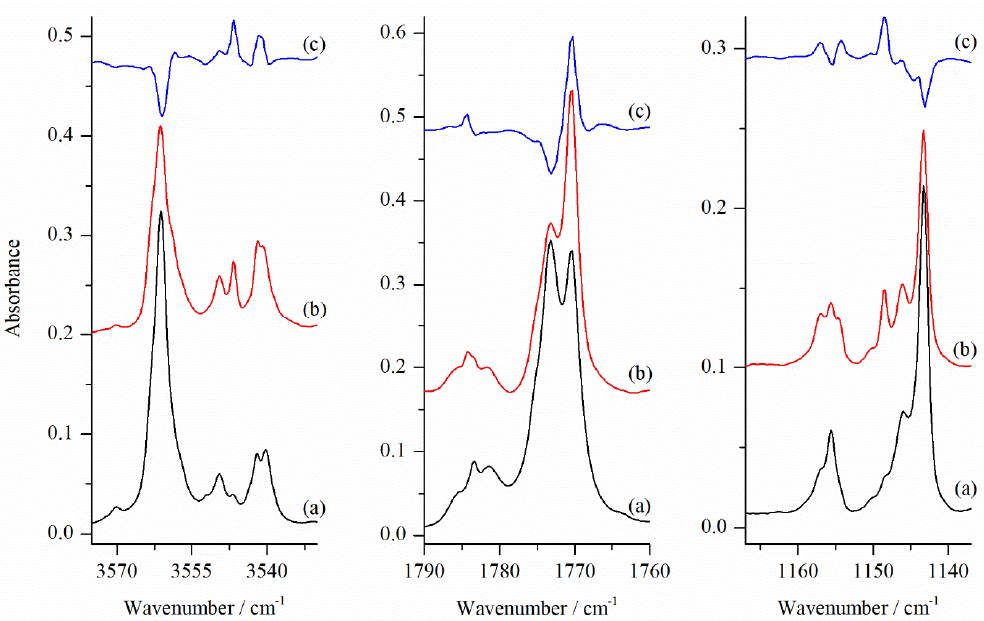
Figure 5. The νOH, δOH C and νC=O regions of the infrared spectra of GA co-deposited with N 2 /Ar = 1/4000 ( a ) at 15 K and ( b ) after annealing at 33 K (measurement at 10 K) and ( c ) the corresponding difference spectrum ( b ) minus ( a ). The bands at 3561.0, 1773.0 and 1143.0 cm −1 belong to the SSC monomer.